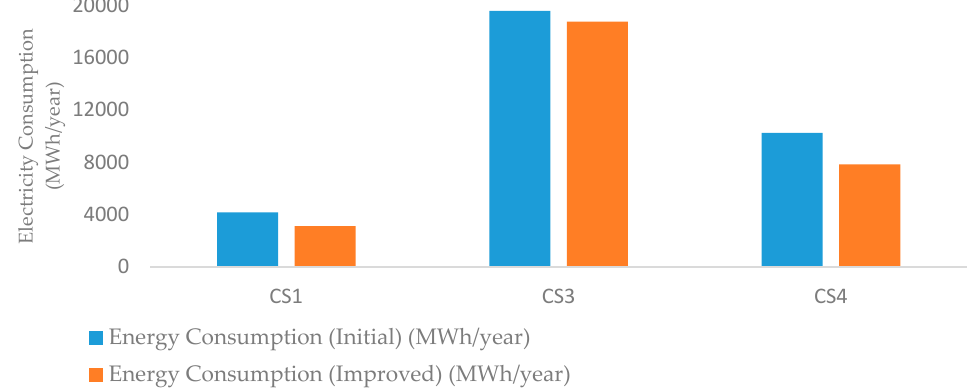
Figure 5. Electricity Consumption for the initial and improved operation of the industrial water circuits (IWC) (High consumption cases).